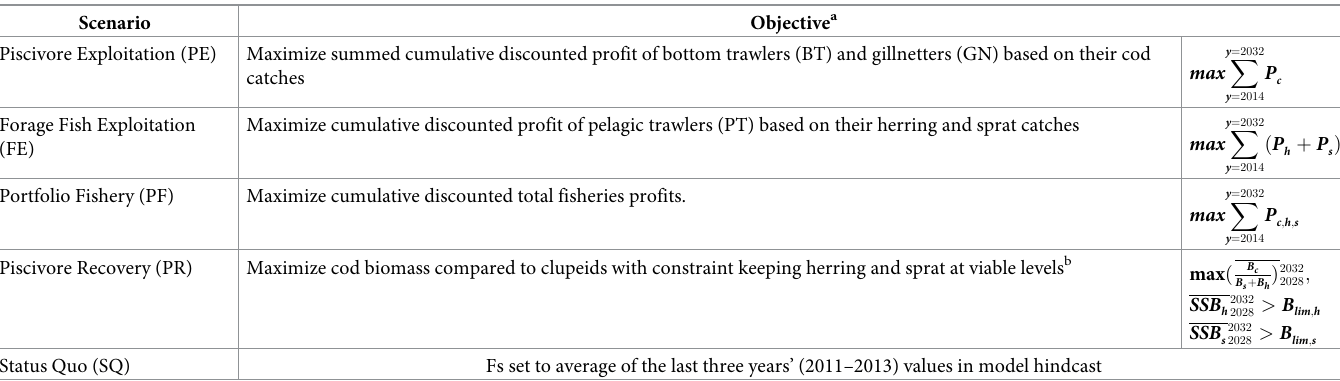
Table 2. Alternative management